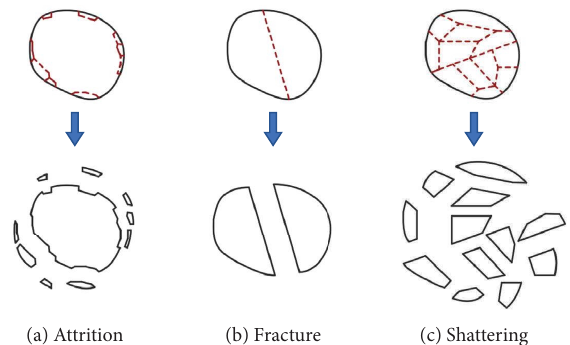
Figure 8: Schematic diagram depicting modes of particle breakage.